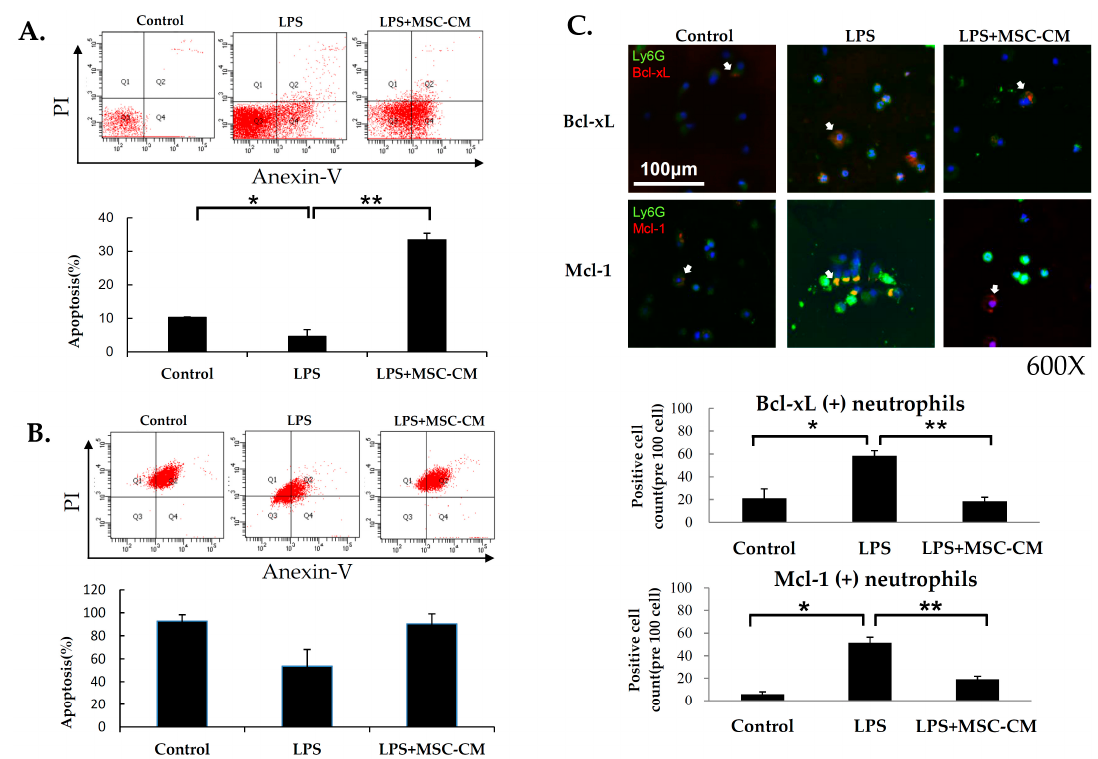
Figure 4. Apoptosis of pulmonary neutrophils were significantly induced by MSC-CM treatment in vivo and vitro models. ( A ) In vivo model, the ratio of apoptotic neutrophils present in BALF samples collected from the mice with LPS-induced ALI (LPS) (4.6 ± 2%) contained a lower ratio of apoptotic neutrophils compared with control mice (Control) (10.3 ± 0.15%). In contrast, the ratio of apoptotic neutrophils was higher in the mice that received LPS + MSC-CM (LPS + MSC-CM) (33.4 ± 2%) than LPS alone (LPS). The bar graph below presents the percentage apoptosis for each experimental group. ( B ) In vitro model, the neutrophils isolated from BALF samples collected from the mice with LPS-induced ALI and cultured 2 h with or without LPS and MSC-CM treatment in vitro. Mouse neutrophils with LPS in vitro stimulation (LPS) (53.7 ± 14.3%) contained a lower ratio of apoptosis compared with control neutrophils (Control) (92.7 ± 5.5%). In contrast, the ratio of apoptotic neutrophils was higher in neutrophils that received LPS + MSC-CM (90.4 ± 8.6%) compared with neutrophils receiving LPS only (LPS). The bar graph below presents the percentage apoptosis for each experimental group. ( C ) Expression of Bcl-xL and Mcl-1 in pulmonary neutrophils of BALF samples increased in the mice with LPS-induced ALI (LPS) compared to the control mice (Control), while treatment with MSC-CM(LPS + MSC-CM)markedly reduced both the expression of Bcl-xL and Mcl-1. Data are presented as the mean ± SD. PI: propidium iodine; Blue: DAPI (4’,6-diamidino- 2-phenylindole); Green (FITC): Ly6G (lymphocyte antigen 6G); Red (Cy5): Bcl-xL or Mcl-1. Magnification = 400 × . Scale bar = 100 µ m. Arrows indicate positive cells. Immunofluoresence intensity was quantitated for the control, LPS, and LPS-MSC tissue sections for the staining of Bcl-xL and Mcl-1 and the data are presented as the mean ± SD. * p < 0.05, compared to the controls; ** p < 0.05, compared to the LPS group; n = 6 per group.